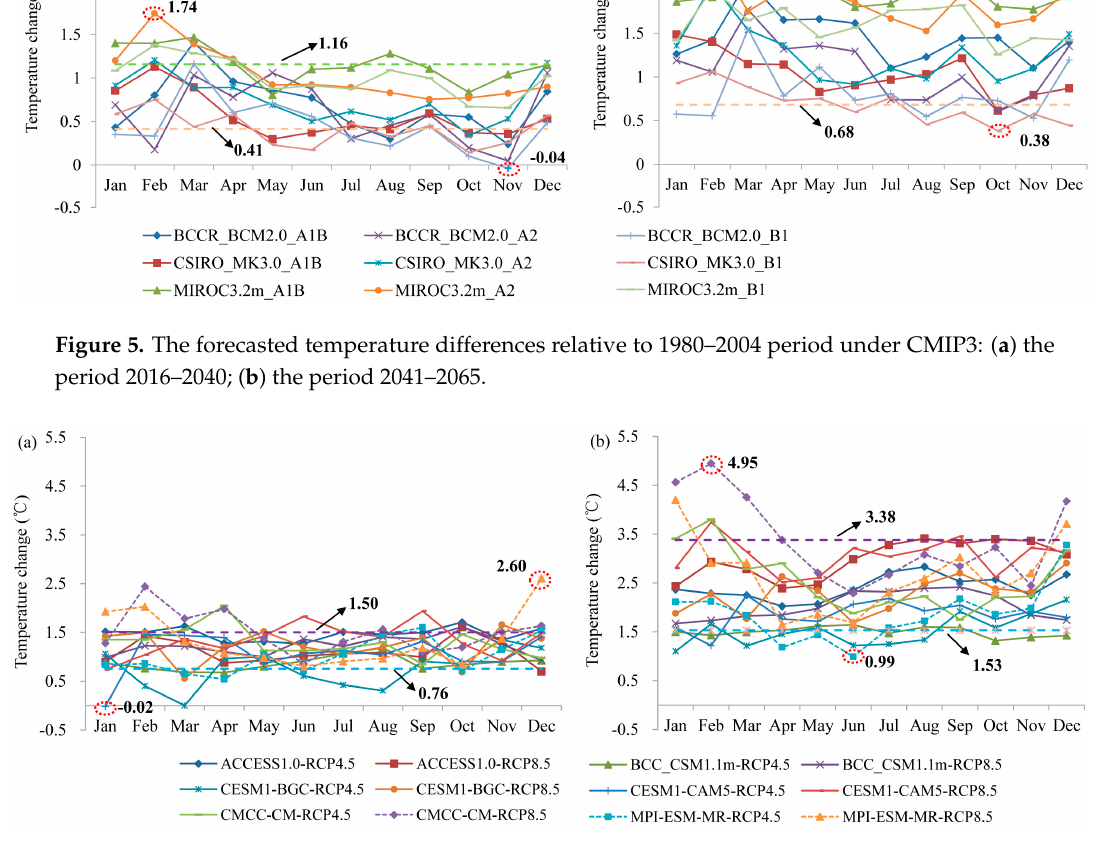
Figure 6. The forecasted temperature differences relative to 1980–2004 period under CMIP5: ( a ) the period 2016–2040; ( b ) the period 2041–2065.